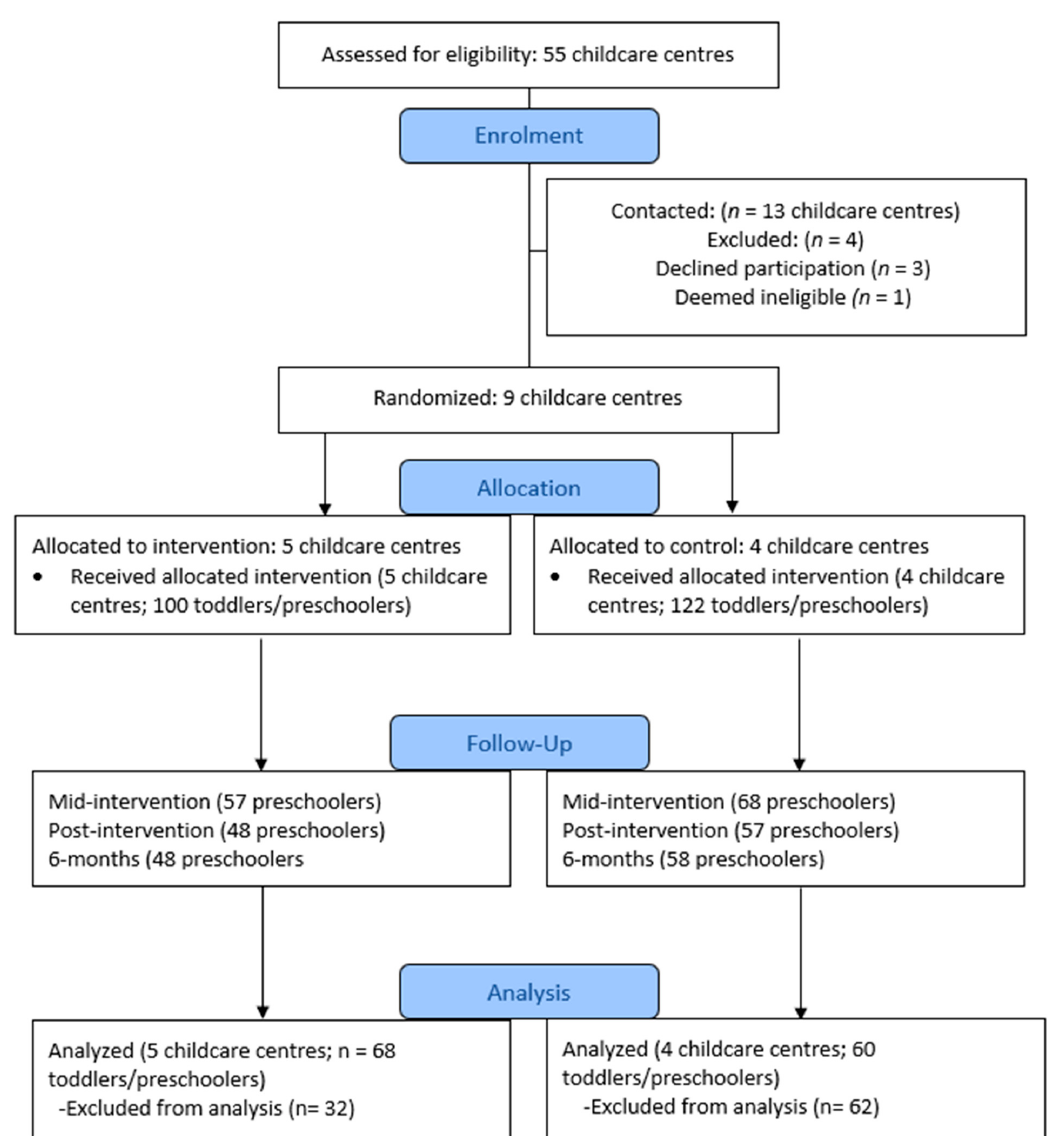
Figure 1. CONSORT flow diagram for the PLAY policy intervention. Note. No centers were lost to follow up or dropped out of the intervention. Toddlers and/or preschoolers were excluded for the following reasons: inadequate wear-time, withdrawal from childcare, device malfunction, and absence from childcare center during data collection periods.